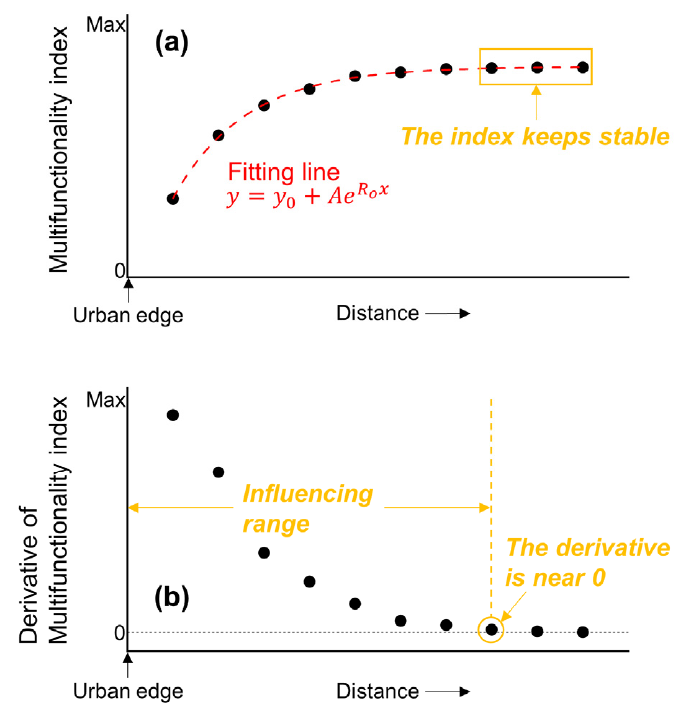
Figure 3. Scatterplots show a method for quantifying the range of the impact of urbanization on landscape multifunctionality. ( a ) The conceptual change of multifunctionality index with the distance. ( b ) The derivative of the multifunctionality index.